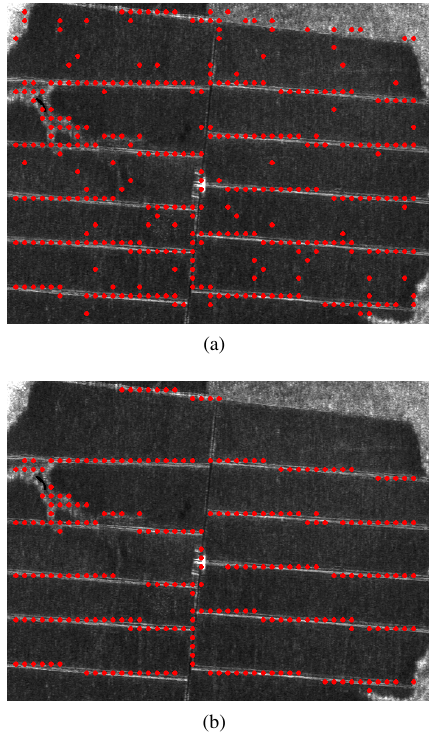
Figure 8: Results of the seeding (Cut 2): (a) Before of pruning process. (b) After of the pruning process.